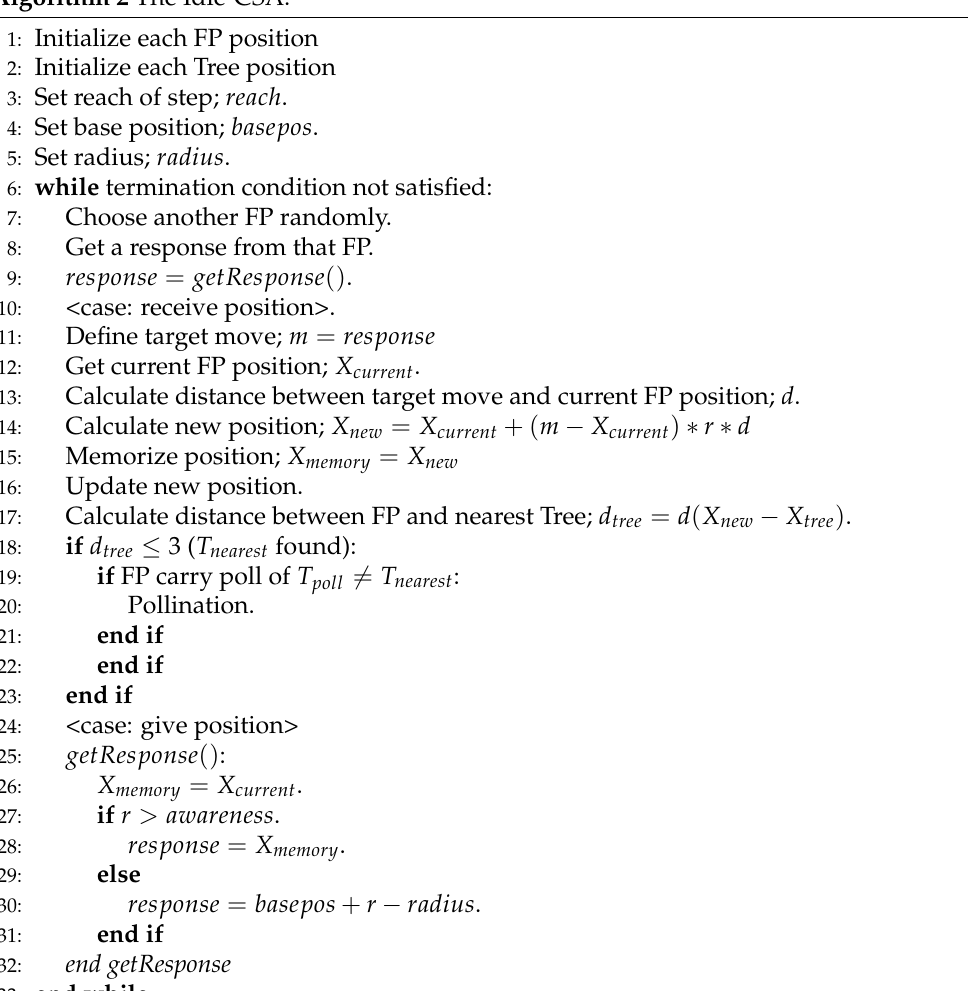
Algorithm 2 The